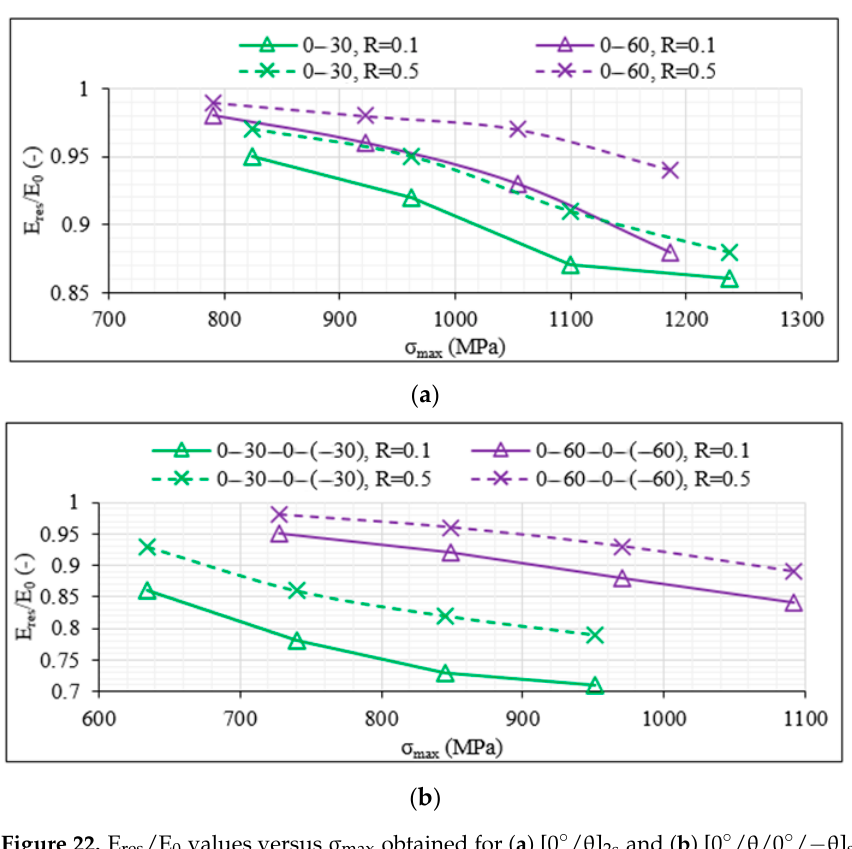
Figure 22. E res /E 0 values versus σ max obtained for ( a ) [0°/ θ ] 2s and ( b ) [0°/ θ /0°/ −θ ] s laminates.